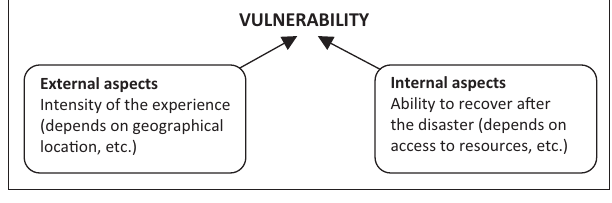
FIGURE 1: Internal and external aspects of